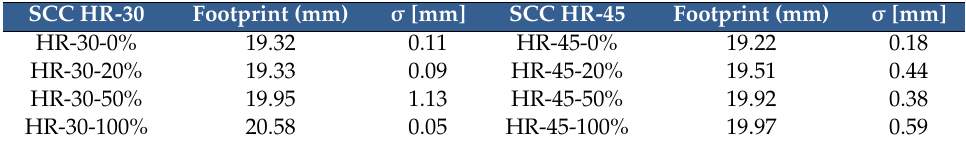
Table 6. Abrasion test results and standard deviation σ